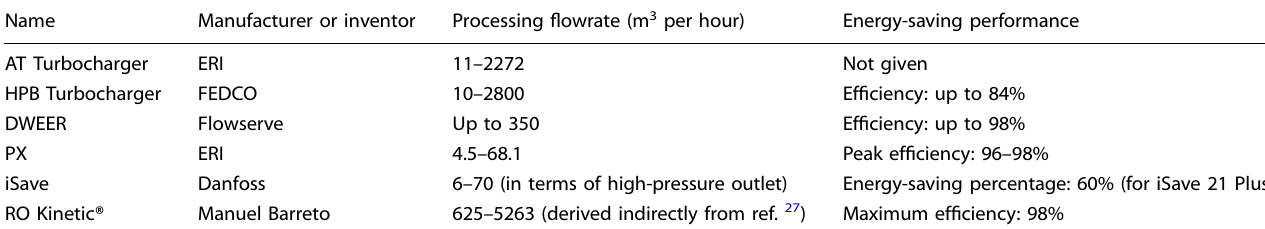
Table 1. The speci fi cations of several kinds of medium to large-scale